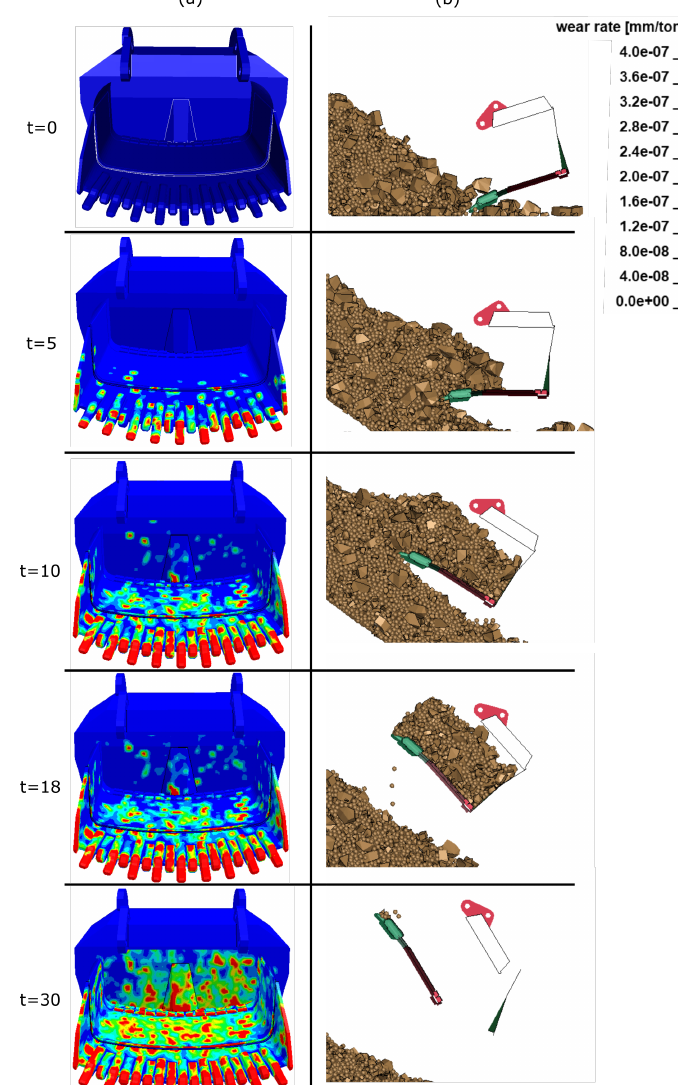
Figure 16. Snapshots from wear simulations during one bucket filling. In column ( a ), the wear is fringe plotted, and in column ( b ), a section view of the bucket and the granular material is shown for the different